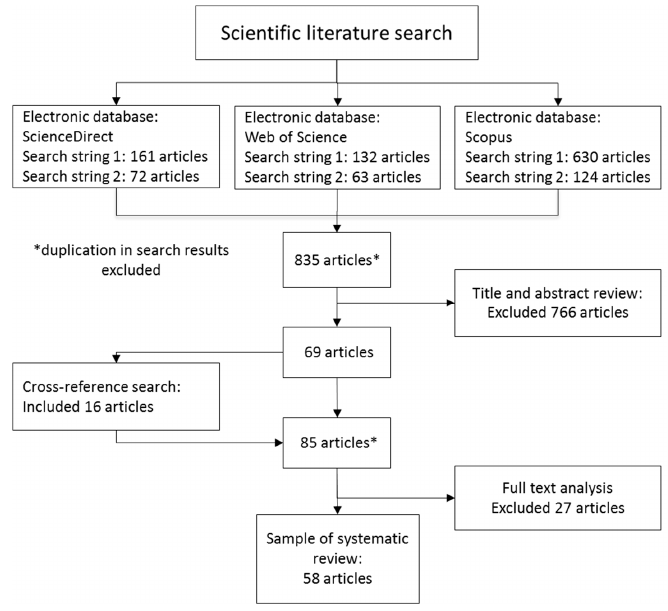
Figure 1. Flow diagram illustrating the review process.